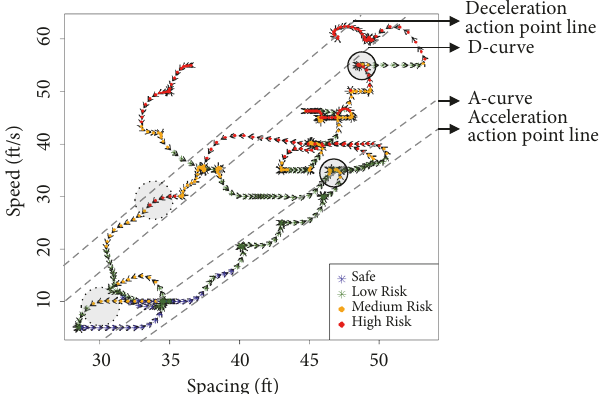
Figure 10: Collision risk estimated with the temporal spacing and speed (SHD).